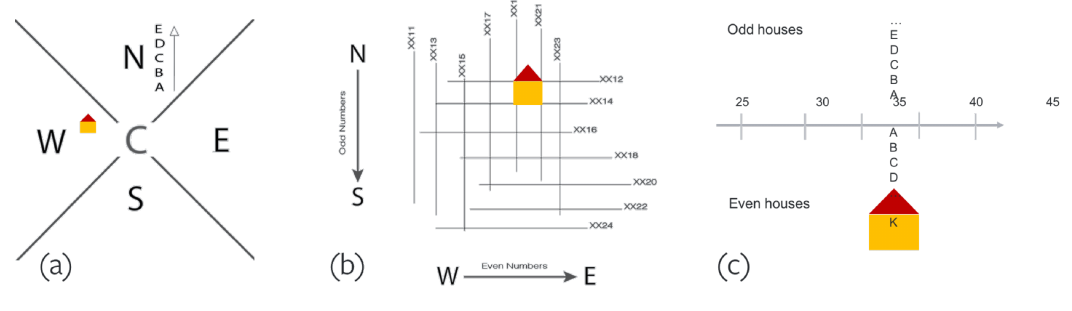
Figure 3. Addressing System. ( a ) Region naming scheme based on orientation and closeness to the city center; ( b ) road naming scheme based on direction and proximity; ( c ) meter marker and block naming scheme based on distance fields. The yellow house has an example address of 38K WB14